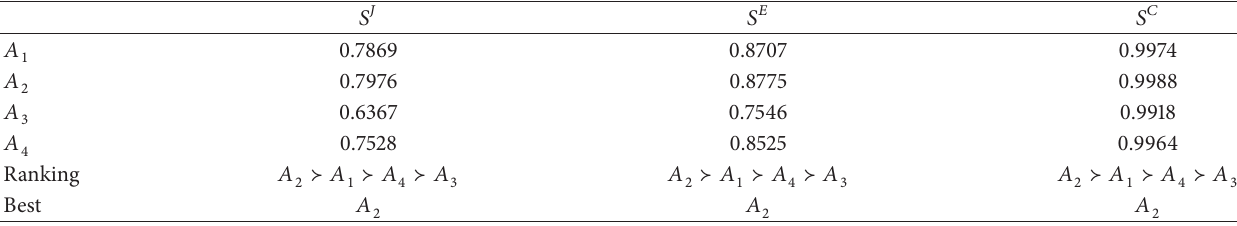
Table 3: Decision results of three weighted similarity measures for TFNs. 𝑆 𝐽